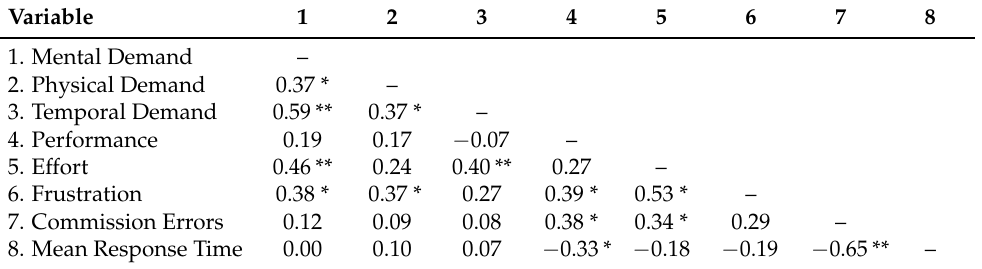
Table 3. Pearson’s correlation coefficients for first round CPT and NASA TLX results.